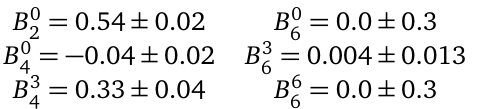
Ti O with uncertainties. 2 2 7